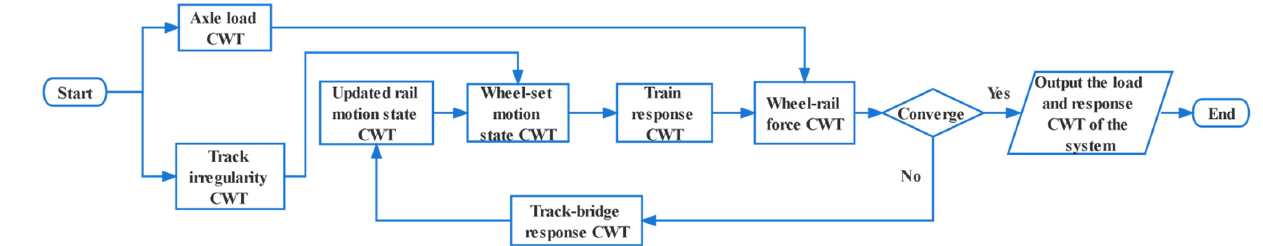
Figure 4. Flowchart of intersystem iteration procedure.